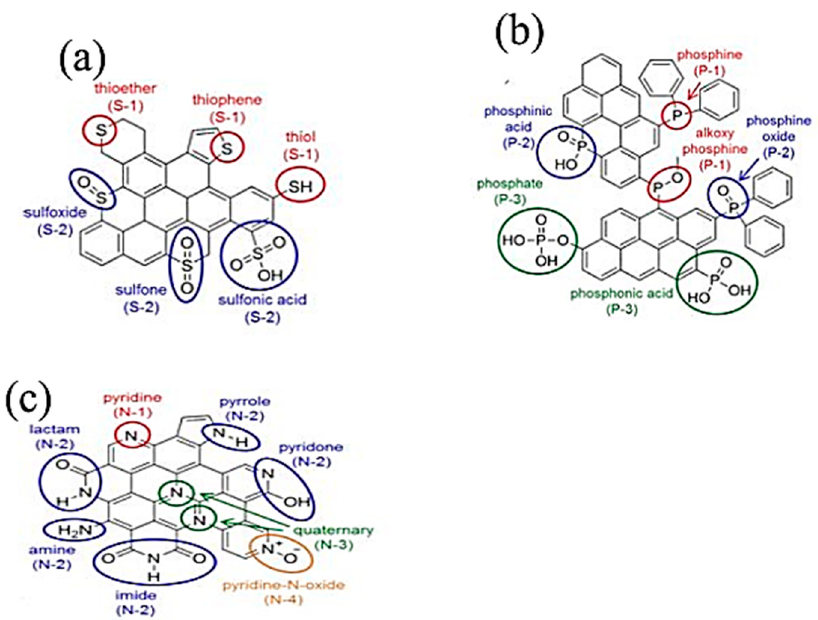
Figure 7. ( a ): Types of S-containing functional groups in a carbon matrix, ( b ): types of P-containing functional groups in a carbon matrix, ( c ): Types of N-containing functional groups in carbon matrix. Adapted with permission from [73]. Copyright (2015) American Chemical Society.